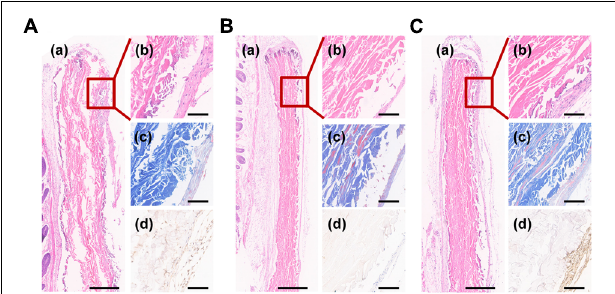
FIGURE 7 | Histological images of (A) ACL and (B) biomimetic cementum without PDLCs and (C) biomimetic cementum seeded with PDLCs. (a,b) indicated the HE staining, (c) indicated Masson trichrome staining, and (d) indicated immunohistochemical staining of CEMP1. Scale bar in a of A – C: 500 µ m. Scale bar in b – d of A – C: 100 µ